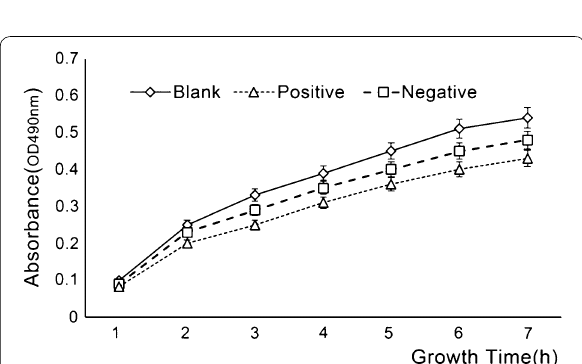
Fig. 5 Effect of HIV-1 protease on IPTG-induced E. coli growth. (Positive control: E. coli in the presence of IPTG and pepstatin A; negative control: E. coli in the presence of IPTG; blank control: E. coli